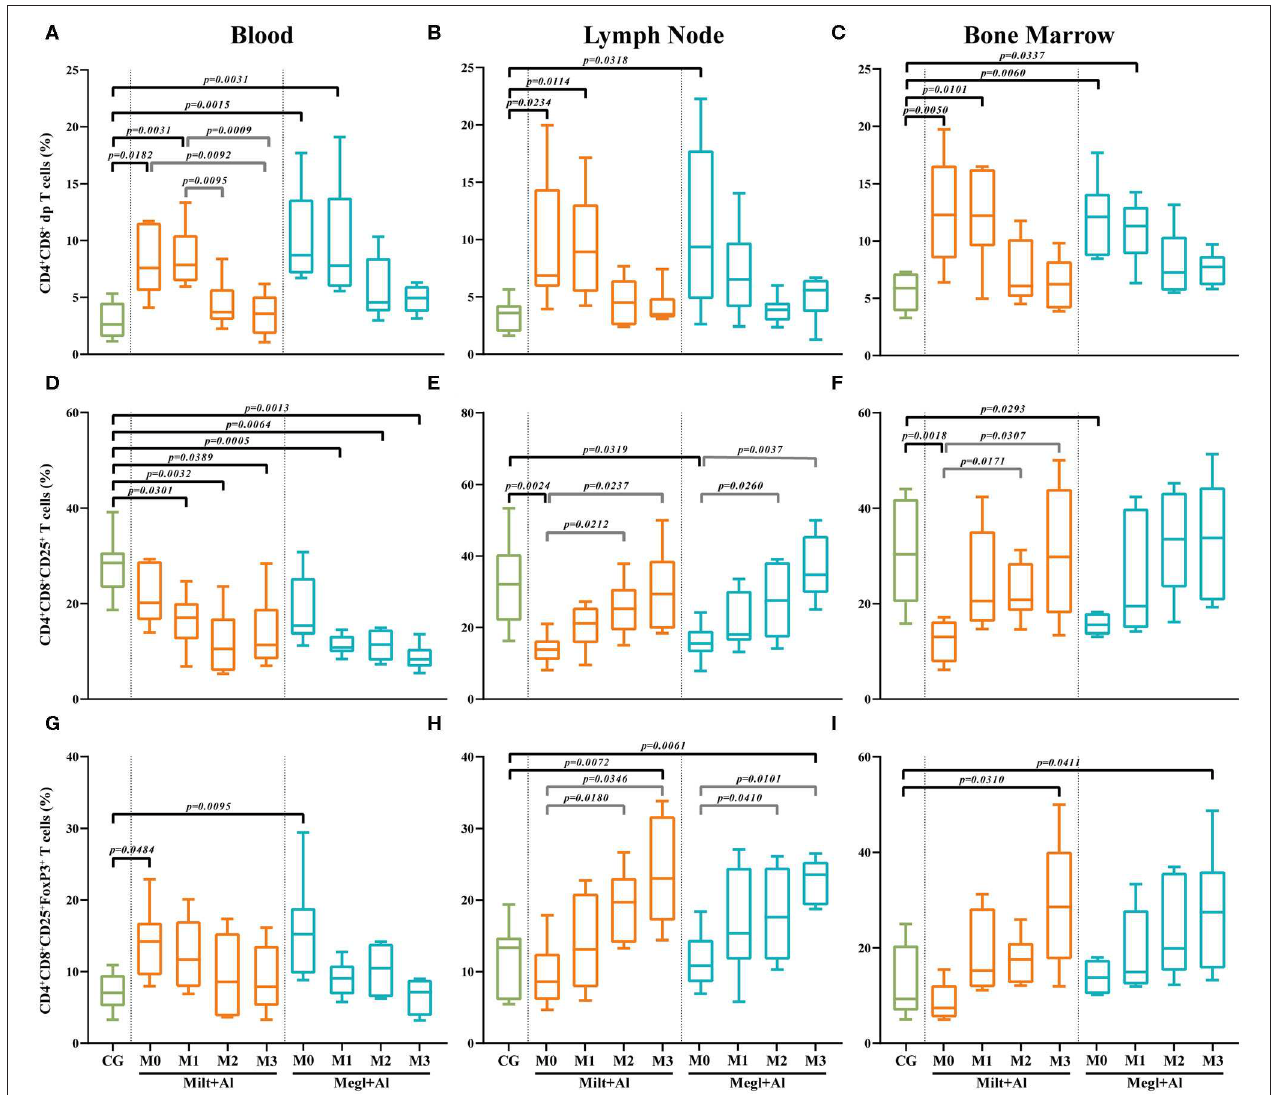
FIGURE 6 | Frequency of CD4 + CD8 + double-positive (dp) T cells. The frequency of dp T cells (A–C) expressing CD25 (D–F) and CD25 and FoxP3 (G–I) was evaluated in the peripheral blood (A,D,G) , lymph node (B,E,H) , and bone marrow (C,F,I) of healthy [control group (CG)], sick (M0), and treated dogs (M1, M2, and M3). Results of 22 dogs are represented by box and whisker plots and median, minimum, and maximum values. The non-parametric Kruskal–Wallis test (one-way ANOVA on ranks) with Dunn’s post hoc test was used for statistical comparisons between treatment groups and the CG. The repeated measures ANOVA test with Tukey’s post hoc test was used for statistical comparisons inside each treatment group. p -values are indicated in every statistically significant comparison.